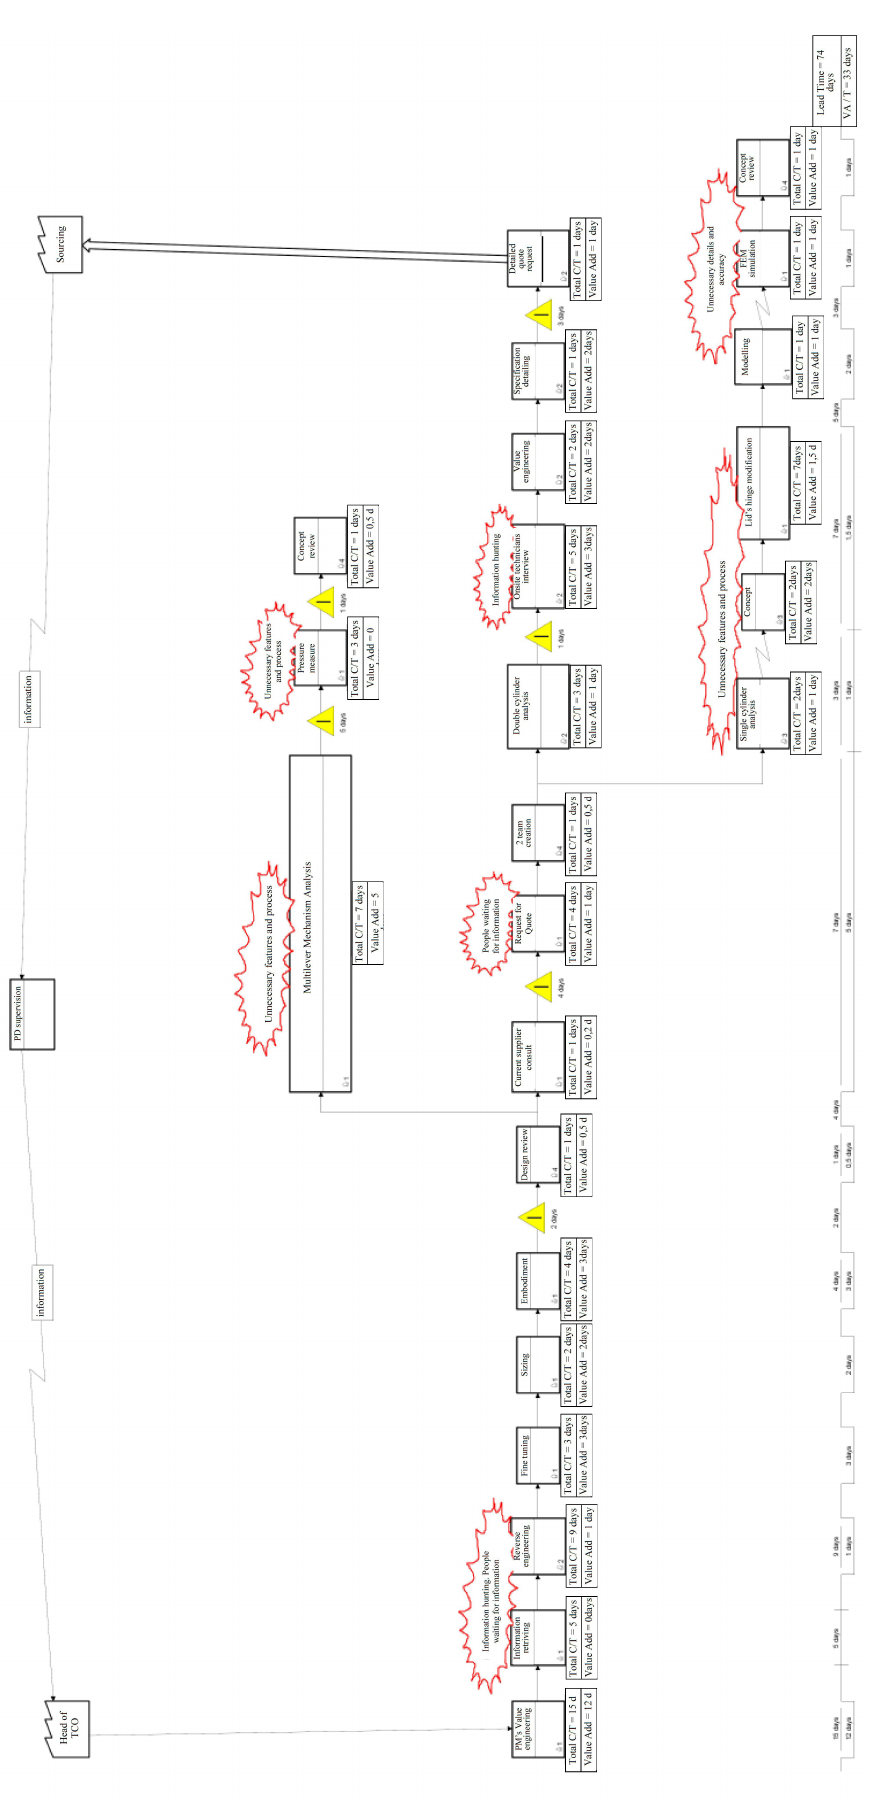
Figure 2. VSM of the project